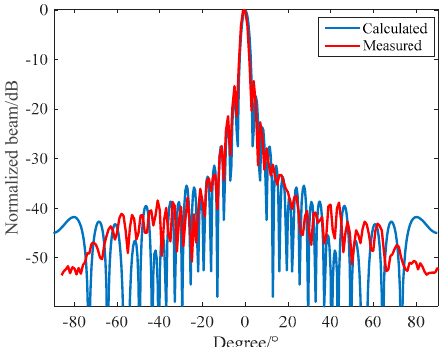
Figure 12. Directionality of the 390 kHz Circular Transmitting Array.